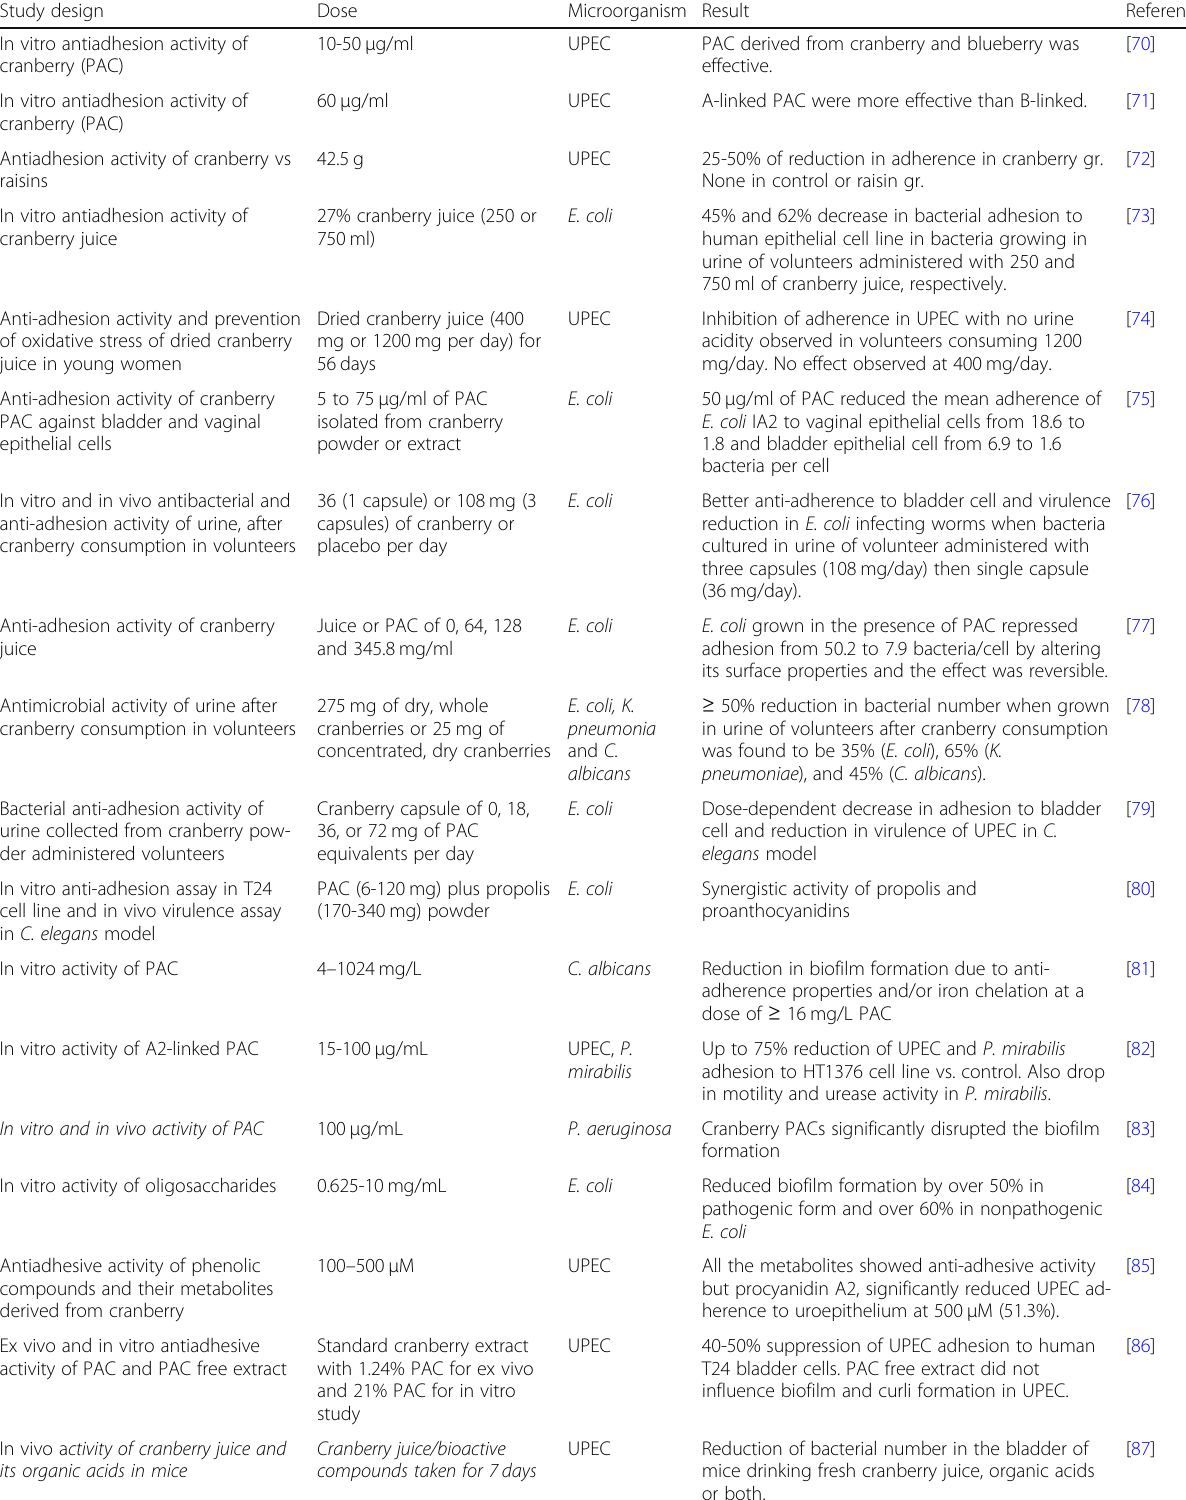
Table 3 In vitro/in vivo activity of cranberries against UTI causing bacteria Study